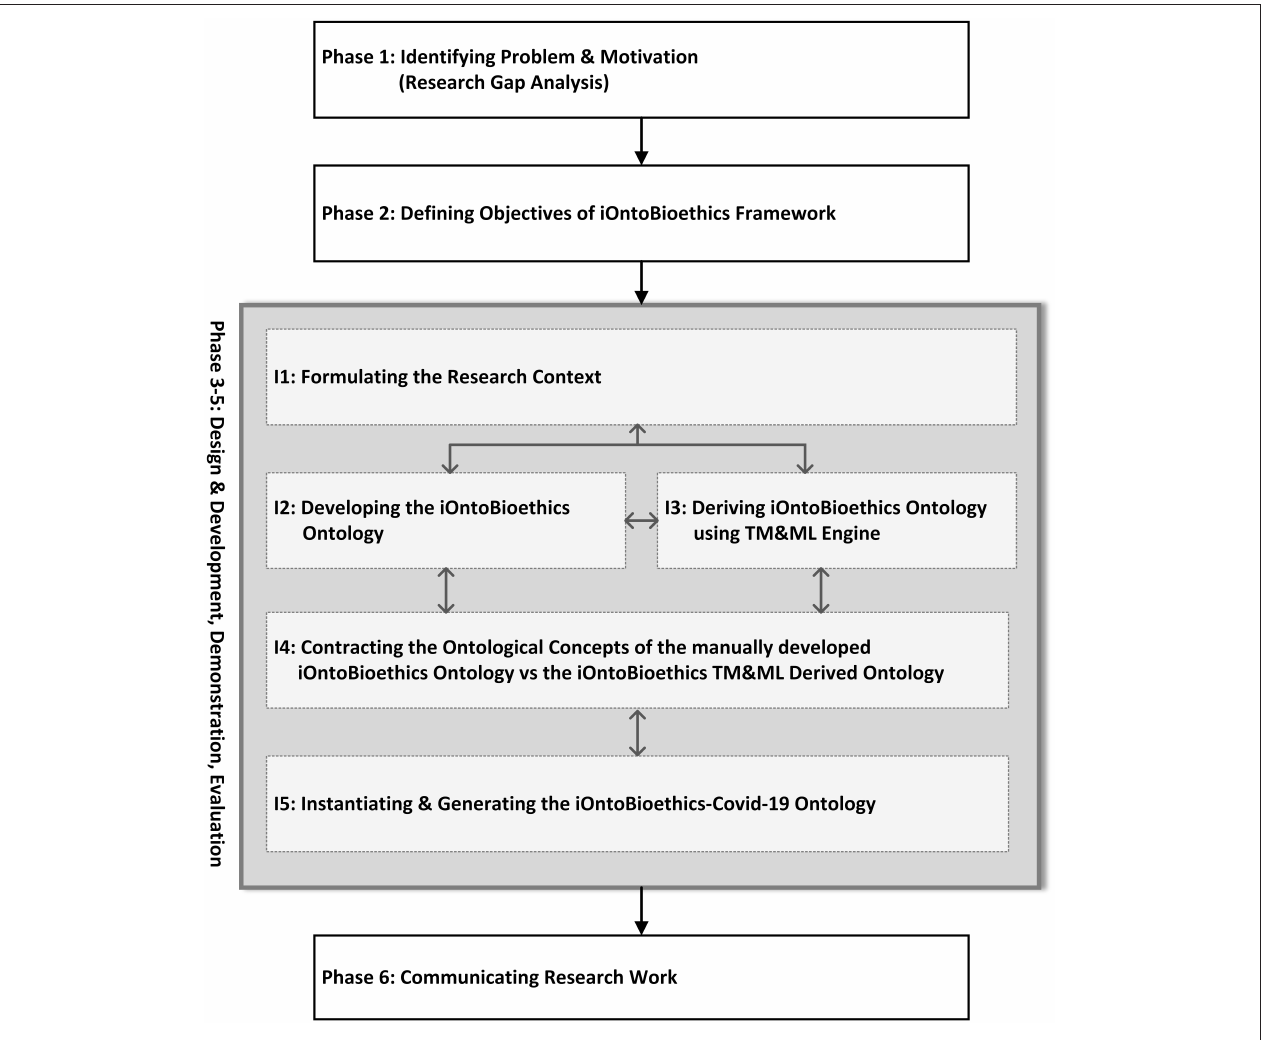
FIGURE 1 | The iOntoBioethics research framework